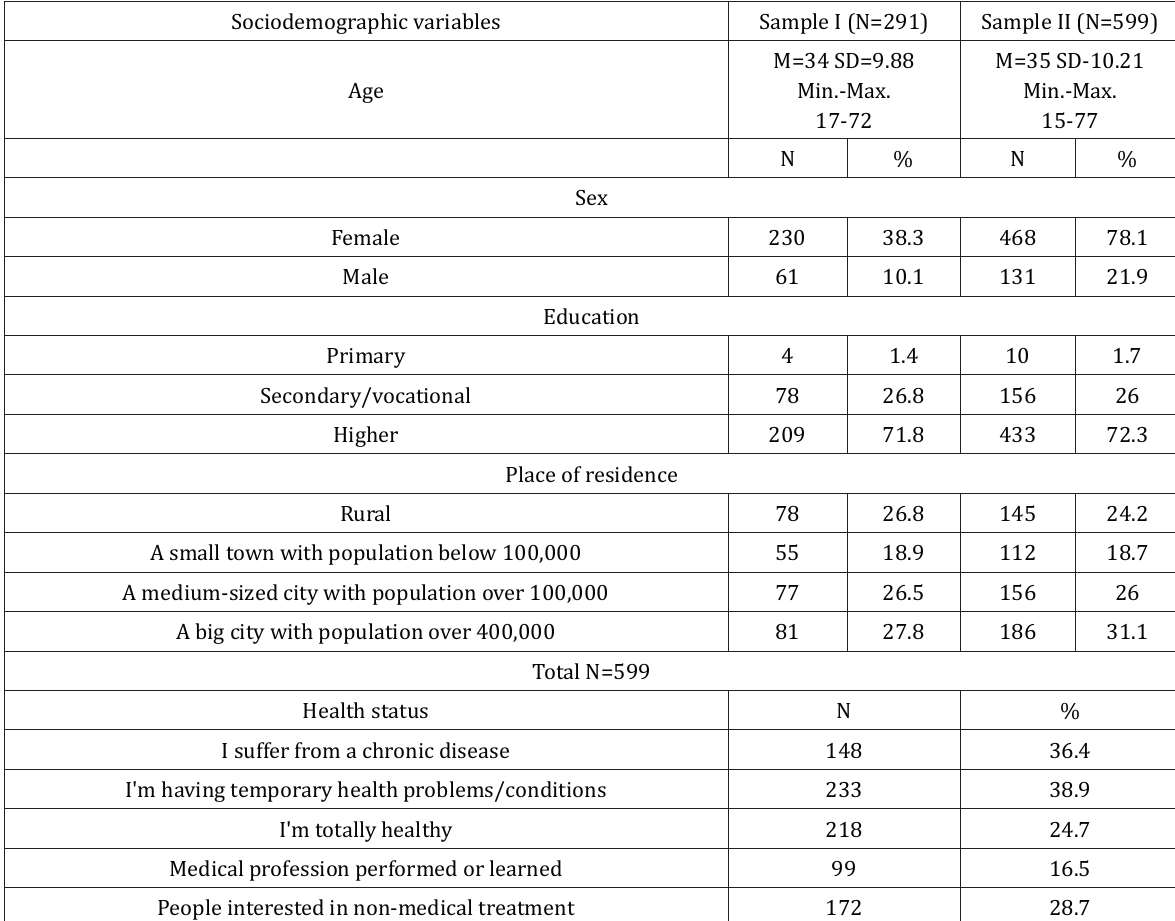
Table 1. Characteristics of the surveyed group